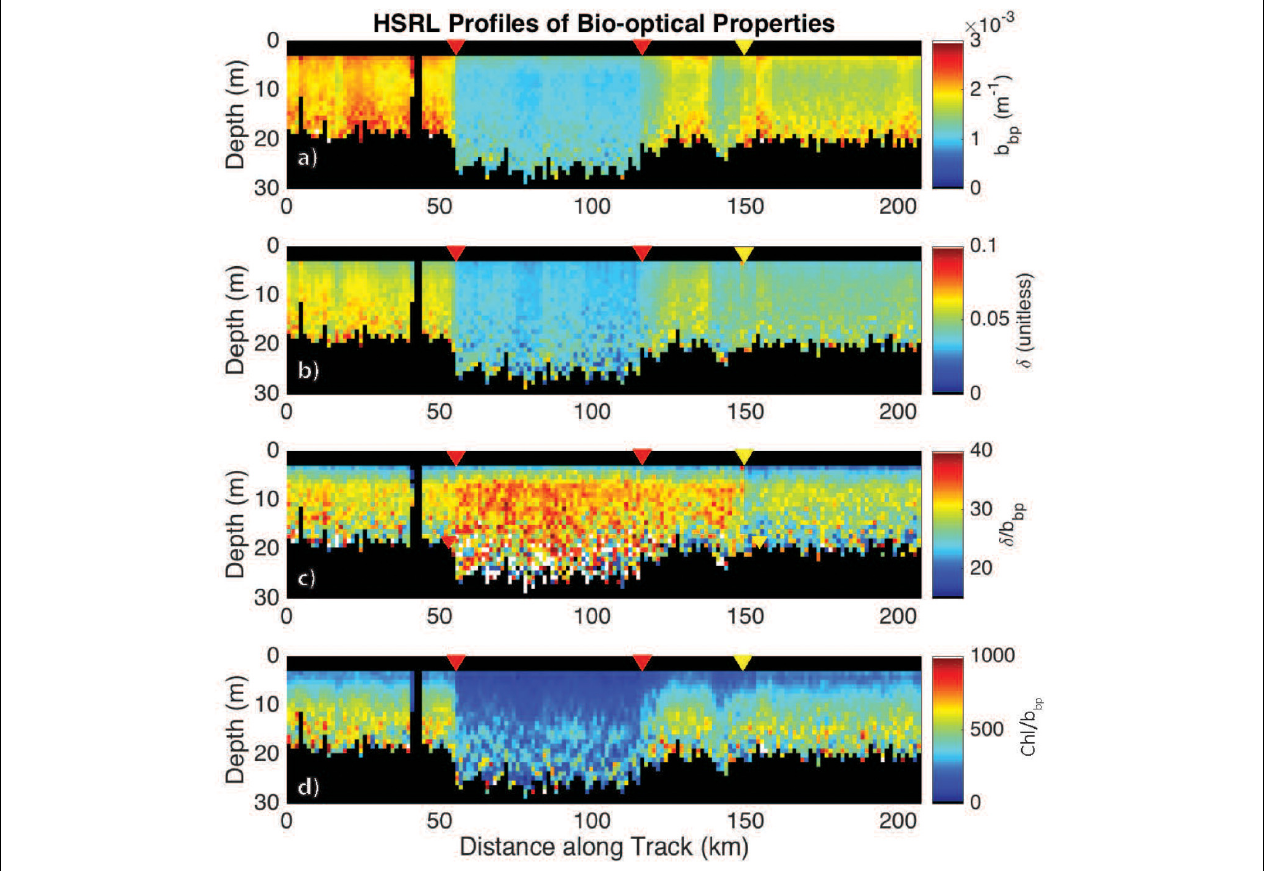
FIGURE 6 | HSRL measurements of (a) b bp , m − 1 ; (b) the depolarization ratio, δ (unitless); (c) the ratio δ / b bp ; and (d) the Chl : b bp ratio across the eddy. The red triangles mark the eddy core boundaries. The yellow triangle marks the boundary in the ratio, b bp / δ . Chl was calculated as a function of K d following Morel et al. (2007).